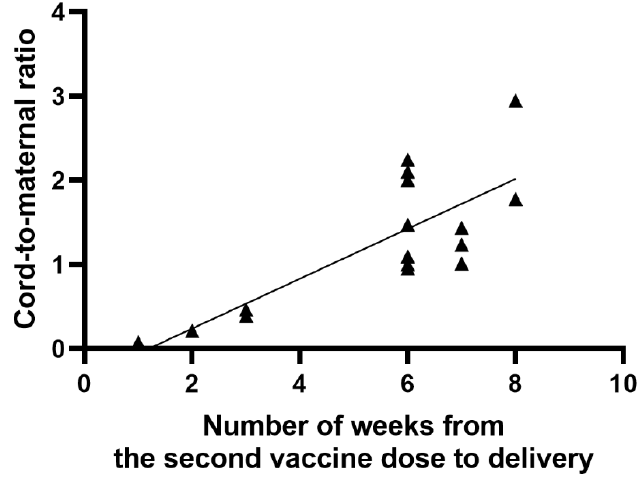
Figure 4. Correlation between the period (weeks) from the first vaccine dose to delivery and cord- to-maternal anti-S titer ratio.